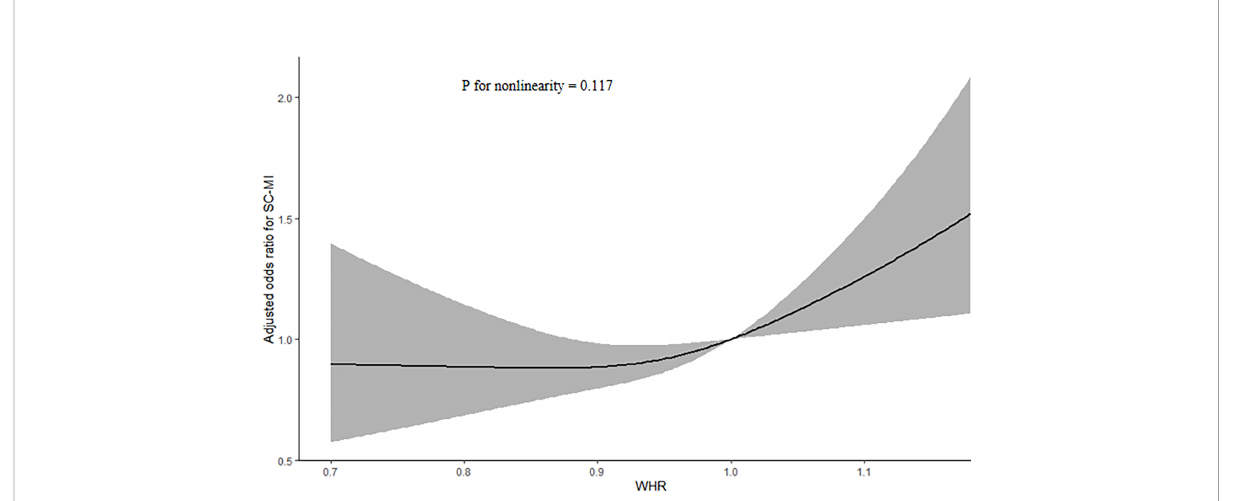
FIGURE 2 Restricted cubic spline plots of the association between WHR and SC-MI. The association was adjusted for variables included in Model 4. WHR waist-hip ratio, SC-MI subclinical myocardial